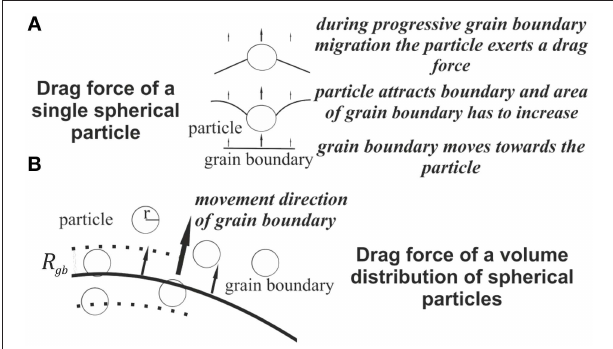
FIGURE 3 | (A) Basic concept of the Zener drag applied to a grain boundary by a single coherent, spherical particle. In the first stage when the grain boundary encounters a particle it will be attract by it. In order to move over the particle the grain boundary has to increase its area which is associated with a higher energy needed for further migration. During progressive grain boundary migration the particle will exert a drag force on the particle. This force is highest for angles of 45 ◦ between the bend grain boundary and an imaginary undeformed boundary. The area increase and the applied drag force from particle result in a higher energy needed for grain boundary migration and therefore slow down or even inhibit further grain boundary migration [after Nes et al. [36]]. (B) Concept of the Zener pressure applied to a grain boundary by multiple spherical, coherent particles of the same radius. The Zener pressure is the drag force of a distribution of particles which are present in the particle-boundary interaction-zone ( R gb ). The assumption for the validity of this concept is that the volume fraction of particles equals the area fraction of particles on the grain boundary [after Nes et al.